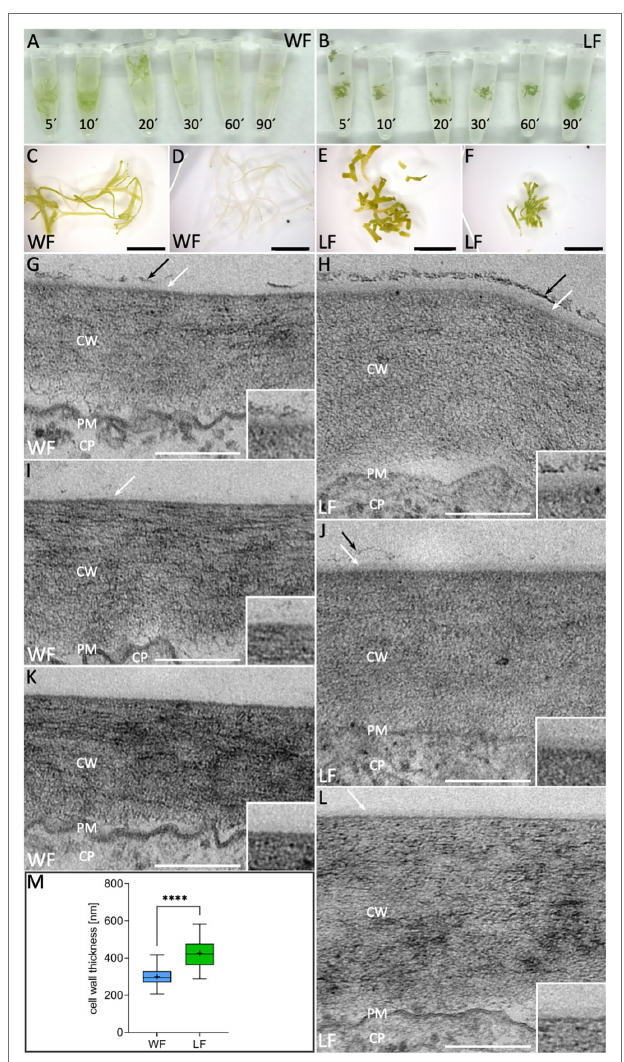
FIGURE 6 | Cell wall and cuticle analyses in R. fluitans . (A) WF and (B) LF thalli after bleaching in ethanol for 5, 10, 20, 30, 60, and 90 min. (C,E) WF/LF thalli after 5 min treatment and (D,F) 120 min. (G,I,K) Cross sections of outer, periclinal cell walls of dorsal WF epidermal cells reveal variable, weak cuticle formation (white arrows). Cuticle is rarely topped with a fragmented additional darker layer (black arrows), likely representing epicuticular waxes (G) . (H,J,L) Corresponding LF cell walls are thicker and cuticle formation is more consistent (white arrows). A darker, patchy putative wax layer of varying thickness was more frequently observed ( H,J , black arrows), but could also be absent (L) . Insets in (G–L) show details of outermost cell wall zones, (K) and (J) are the most representative images for WF and LF, respectively. CW, cell wall; PM, plasma membrane; and CP, cytoplasm. (M) Quantification of outer cell wall thickness in WF (blue) and LF (green) dorsal epidermal thallus cells (WF, n = 69 cells of three individual thalli; LF, n = 74 cells of three individual thalli; **** p < 0.0001). Scale bars: (C–F) 5 mm; (G–L) 200